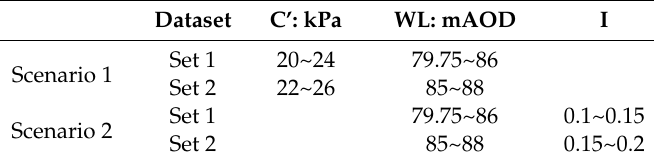
Table 3. Input random sets for two design